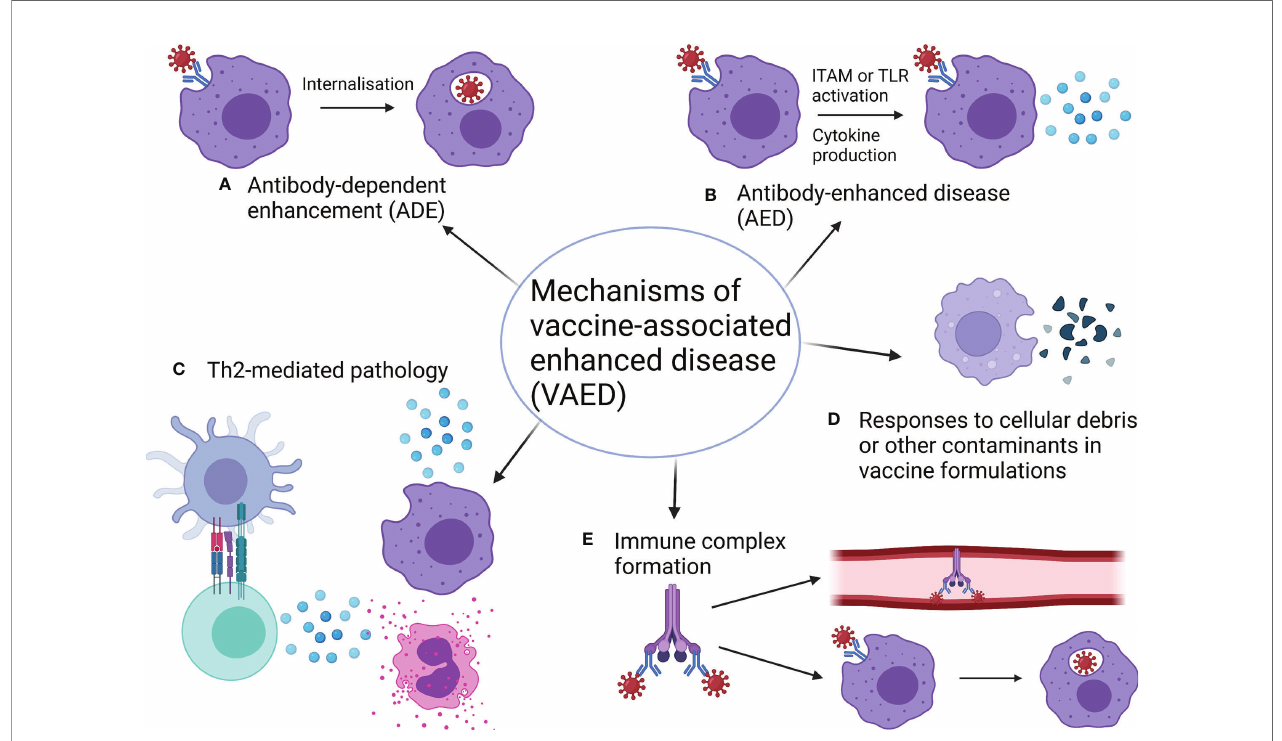
FIGURE 1 | Mechanisms of vaccine-associated enhanced disease. (A) Antibody-dependent enhancement (ADE) occurs when antibodies increase the ability of a virus to infect cells (also see Figure 2 ). (B) Antibody-enhanced disease (AED) occurs when antibodies exacerbate in fl ammation, resulting in pathology (also see Figure 2 ). (C) Th2-skewed responses can be pathogenic for some infections and so vaccines that induce Th2 responses in this case can cause pathology. Usually Th2 pathology is associated with eosinophil in fi ltration. (D) Components of vaccine formulations such as bovine serum albumin (BSA) and cellular debris can mediate pathogenic cellular responses to these components when encountered again as contaminants in the challenge material. While these components are normally removed during vaccine preparation, some preclinical studies have not included appropriate washing and centrifugation steps to facilitate this. (E) Immune complexes between viral proteins, antibodies and/or complement can lead to a build-up of deposits in blood vessels and organs or facilitate enhanced uptake of virus through myeloid cells, causing ADE. Both of these outcomes can enhance pathology. Made with